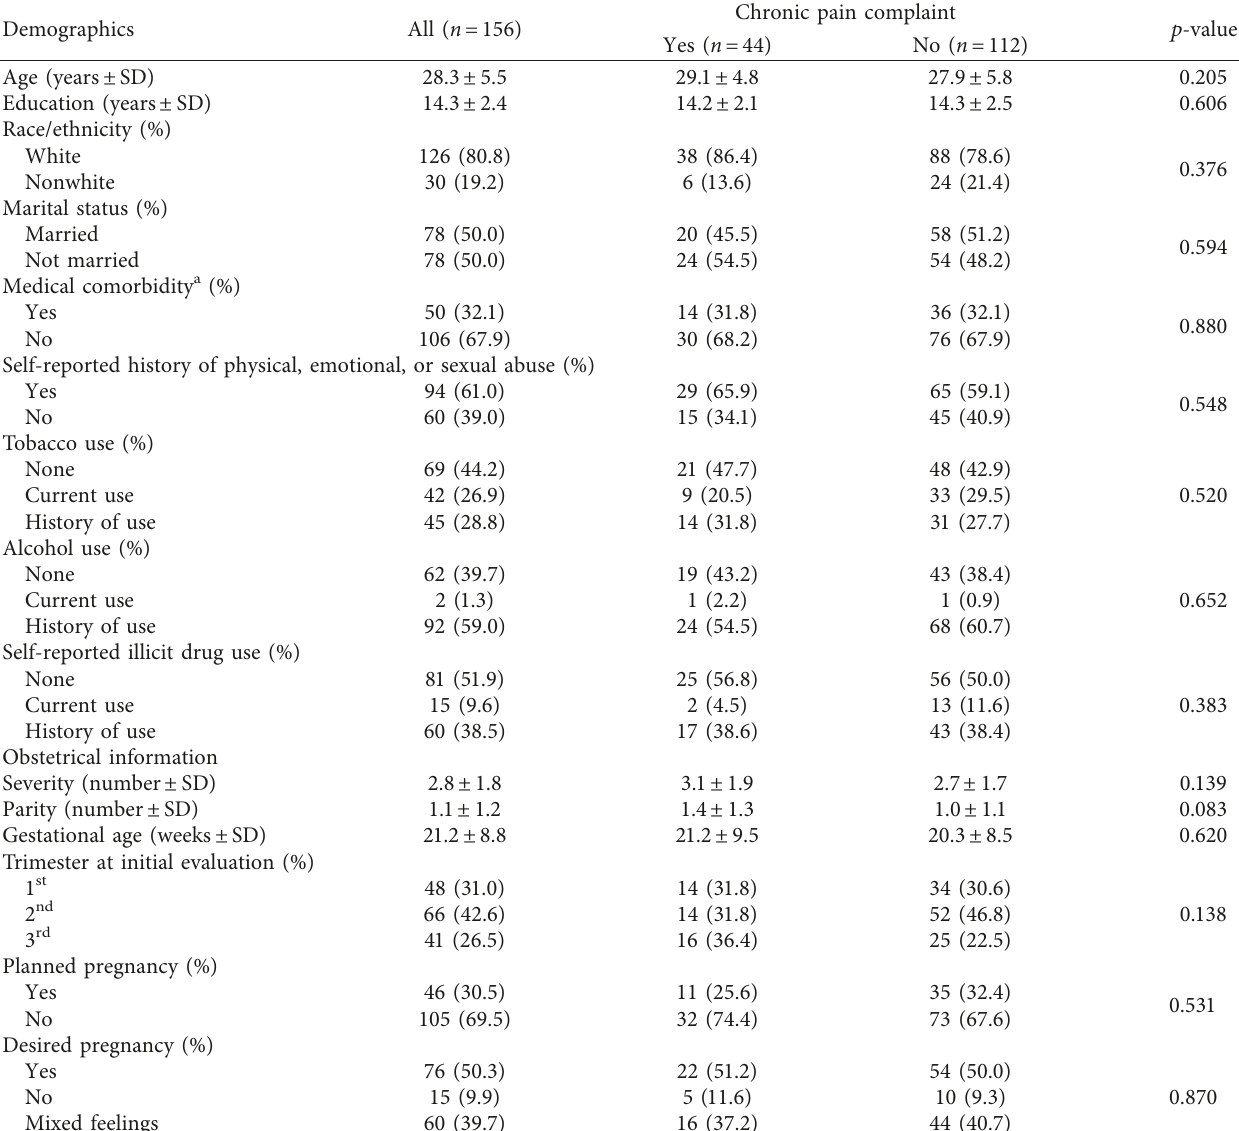
Table 1: Demographic and medical history of pregnant women in a perinatal mood disorder